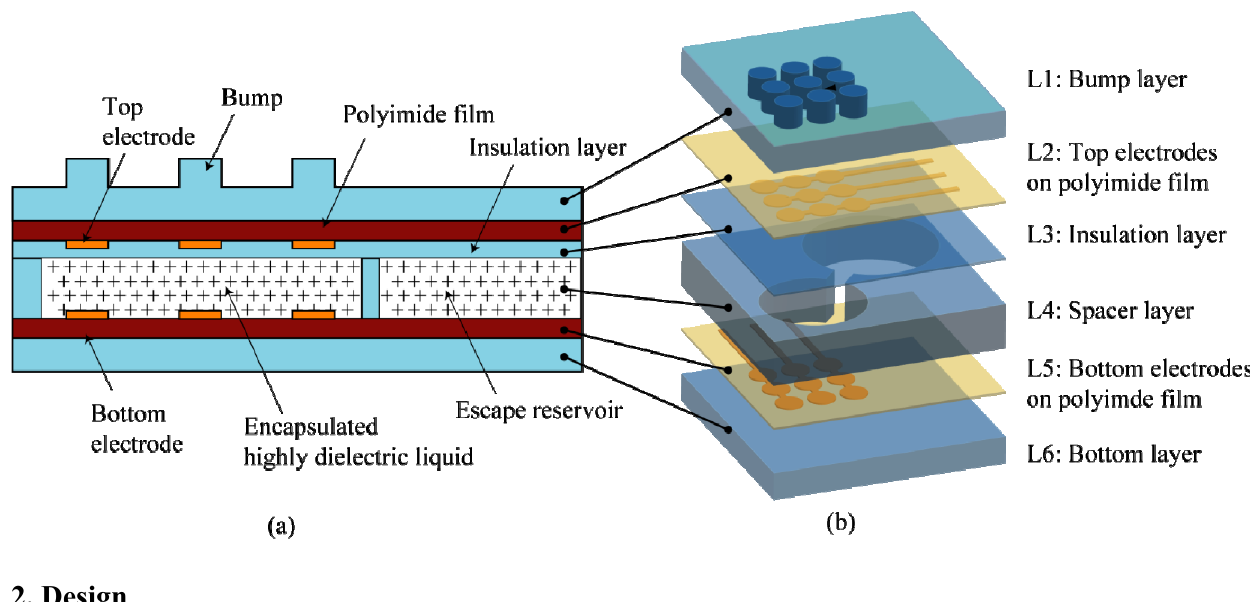
Figure 1. ( a ) A schematic cross-sectional image of the proposed sensor. ( b ) An exploded drawing of the sensor